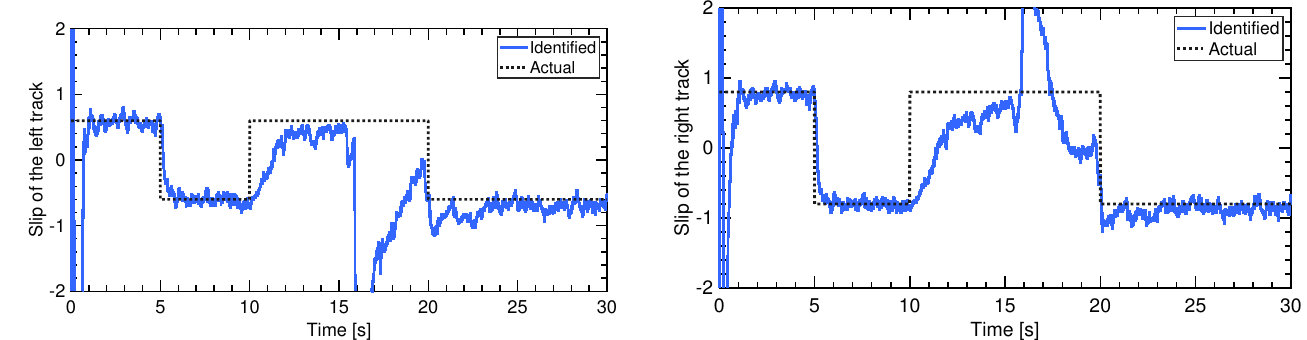
Figure 33. Track slip ratio identification: Left track ( left ) and Right track ( right ).